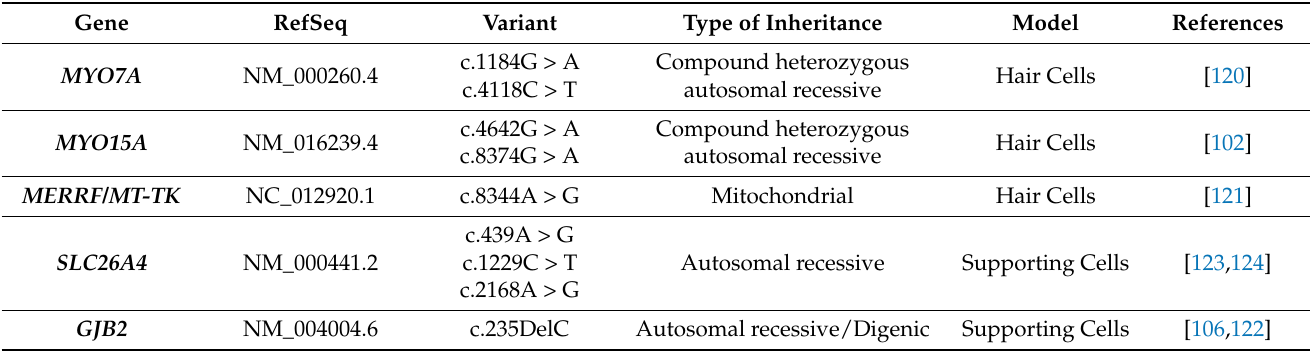
Table 2. Genetic mutations causing inner ear disorders modeled using hPSCs. Gene RefSeq Variant Type of Inheritance